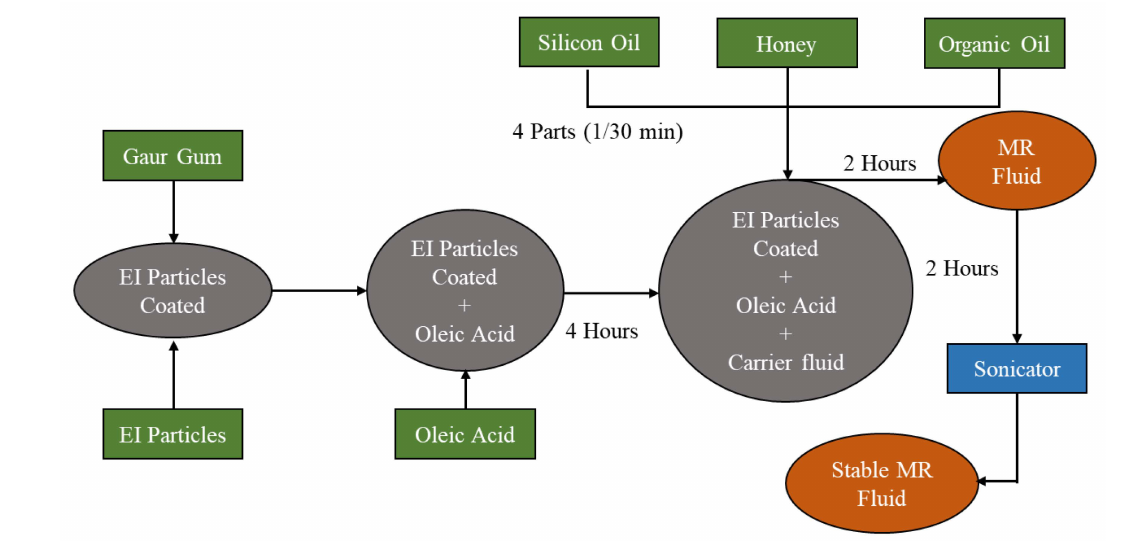
Figure 3. The manufacturing process of magnetorheological fluids featuring various base oils [39]. Table 2. Base Oil Modification for Improvement of Sedimentation